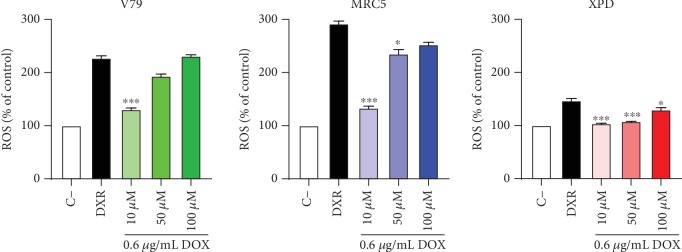
Effect of DPDT on DOX-induced ROS generation and ROS induction was evaluated via flow cytometry using DCFH-DA in cells pretreated with DPDT for 2 h in serum-free medium, followed by treatment with doxorubicin for 3 h. V79: Chinese hamster fibroblasts; MRC5 and XPD: human fibroblasts proficient and deficient in NER, respectively. Data are reported as means ± SD of three independent experiments. Significantly different at ∗p < 0.05, ∗∗p < 0.01, and ∗∗∗p < 0.001 compared with cells treated with doxorubicin only (one-way ANOVA followed by Tukey test).